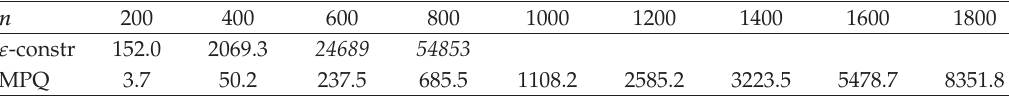
Table 1: Comparison between the ε -constraint and the MPQ method (cid:6) taken from (cid:4) 8 (cid:5)(cid:7) . The first column contains the number of assets, the second one the average CPU-time in seconds for the ε -constraint method calculating a 20-point sample of the e ffi cient frontier (cid:6) the numbers in italics being estimates (cid:7) , and the third one contains the average CPU-time of the MPQ method calculating the exact e ffi cient frontier.